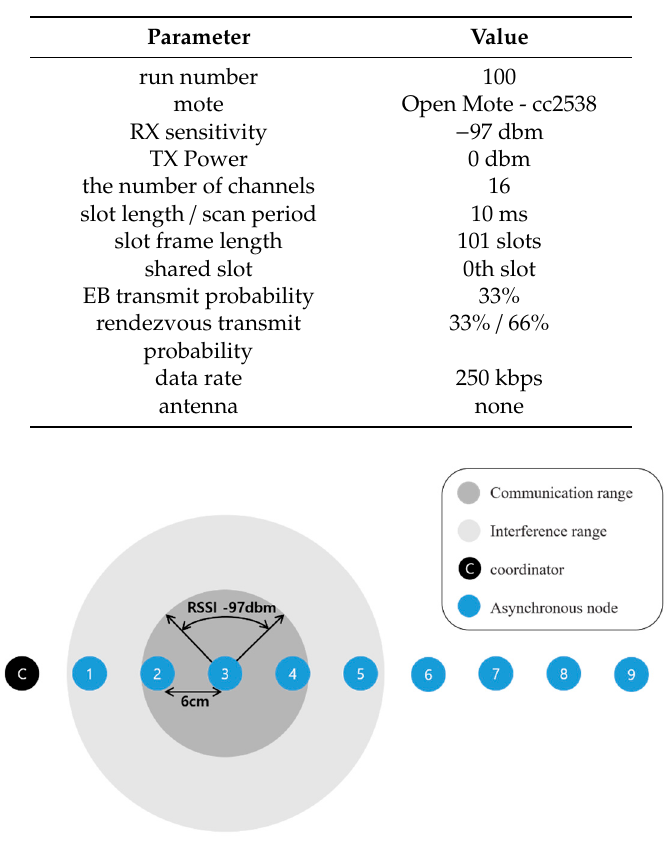
Table 1. Experiment Parameter Value.